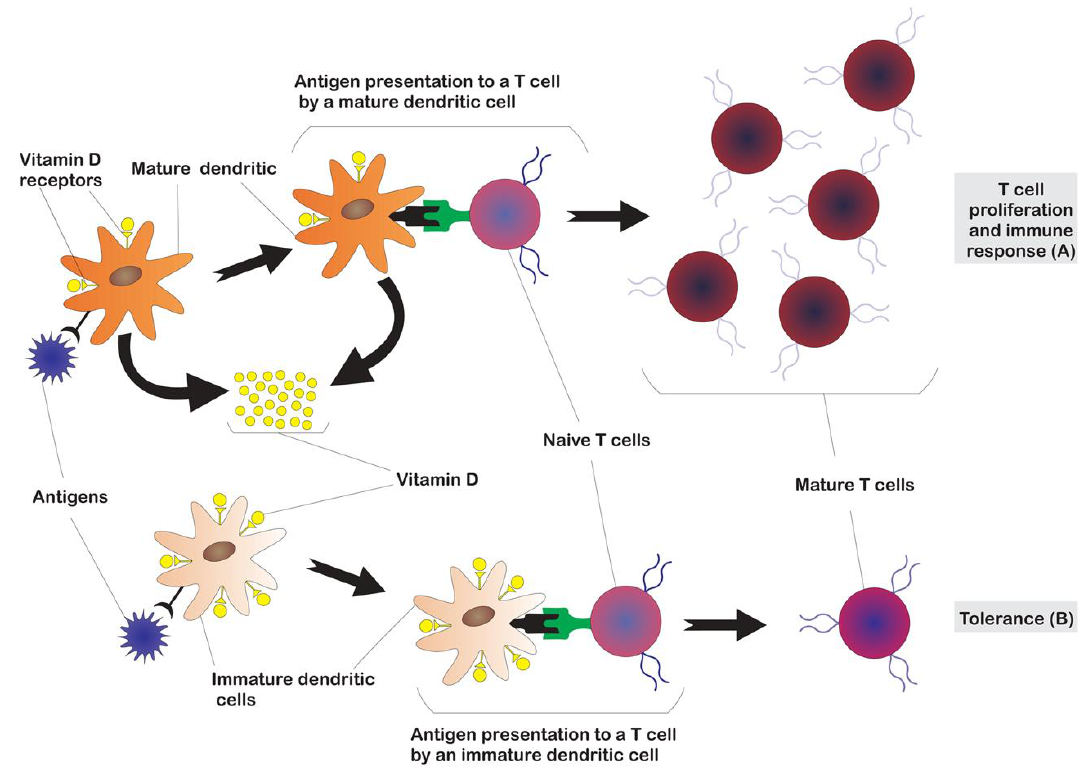
Figure 3. Influence of vitamin D in activation of adaptative immunity. The different results of antigen presentation to T cells by mature vs. immature dendritic cells, leading to immune response ( A ) or tolerance ( B ), respectively, are depicted. Vitamin D inhibits the maturation of dendritic cells, maintaining a more tolerogenic phenotype. Mature dendritic cells have less vitamin D receptor (VDR) but synthesize 1,25(OH) 2 D, which acts on a paracrine level on immature dendritic cells and prevents their excessive proliferation.